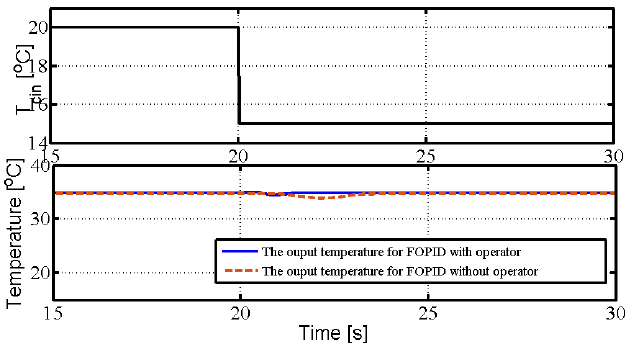
Figure 20. Antidisturbance performance to the input temperature of cold-fluid